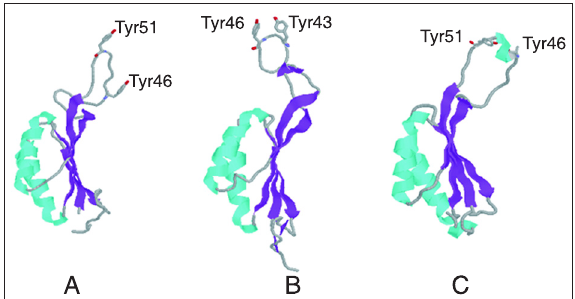
Figure 1. Monomeric structure of the PII family proteins: Escheri- chia coli GlnB (A), Streptococcus mutans GlnK model (B) and E. coli GlnK (C). The structures of the E. coli GlnB and GlnK proteins were obtained from the Protein Data Bank (ID: 2pii and 1GlK, respectively) and the structural model of the S. mutans GlnK protein was obtained using the 3D-JIGSAW program (24). The structural models were designed using the RasMol program (39). The S. mutans GlnK presents a Tyr43 and Tyr46 residue on the protein surfaces as the residues Tyr46 and Tyr51 from E. coli GlnB and GlnK.